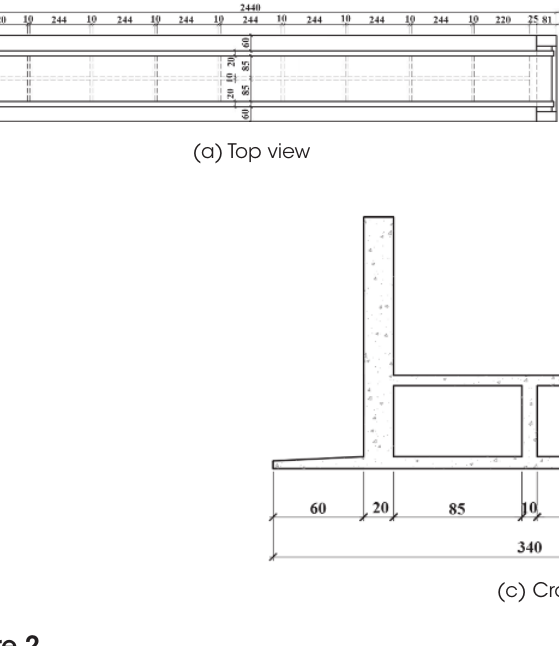
Structural model design (dimensions in cm)